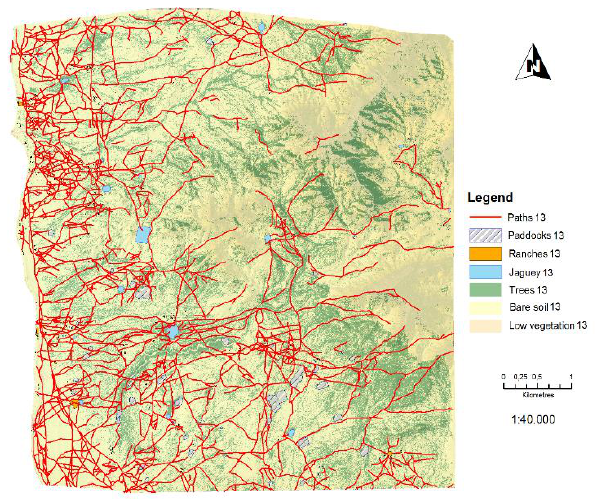
Figure 9. Land use and cover 2013.